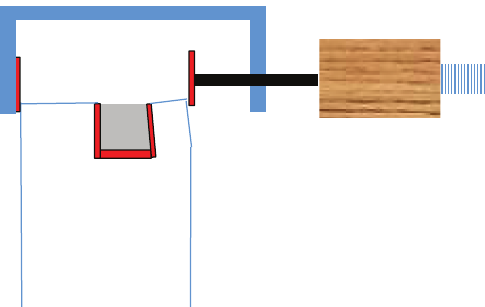
Figure 3: Illustration of shrinkage-induced cusp deformation and the measurement tool. Micrometer contact surface and line are